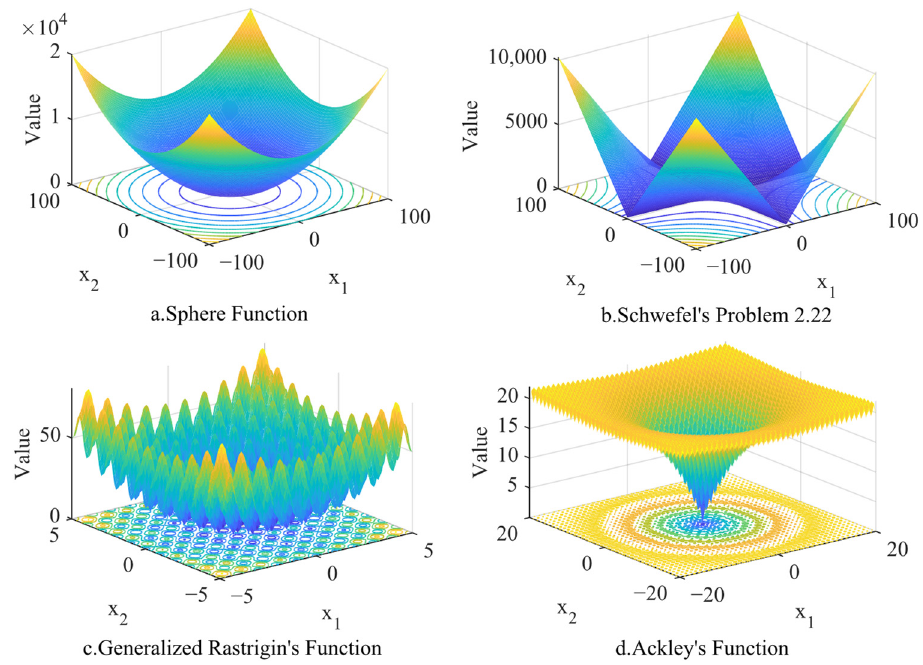
Figure 2. Images of the test function.